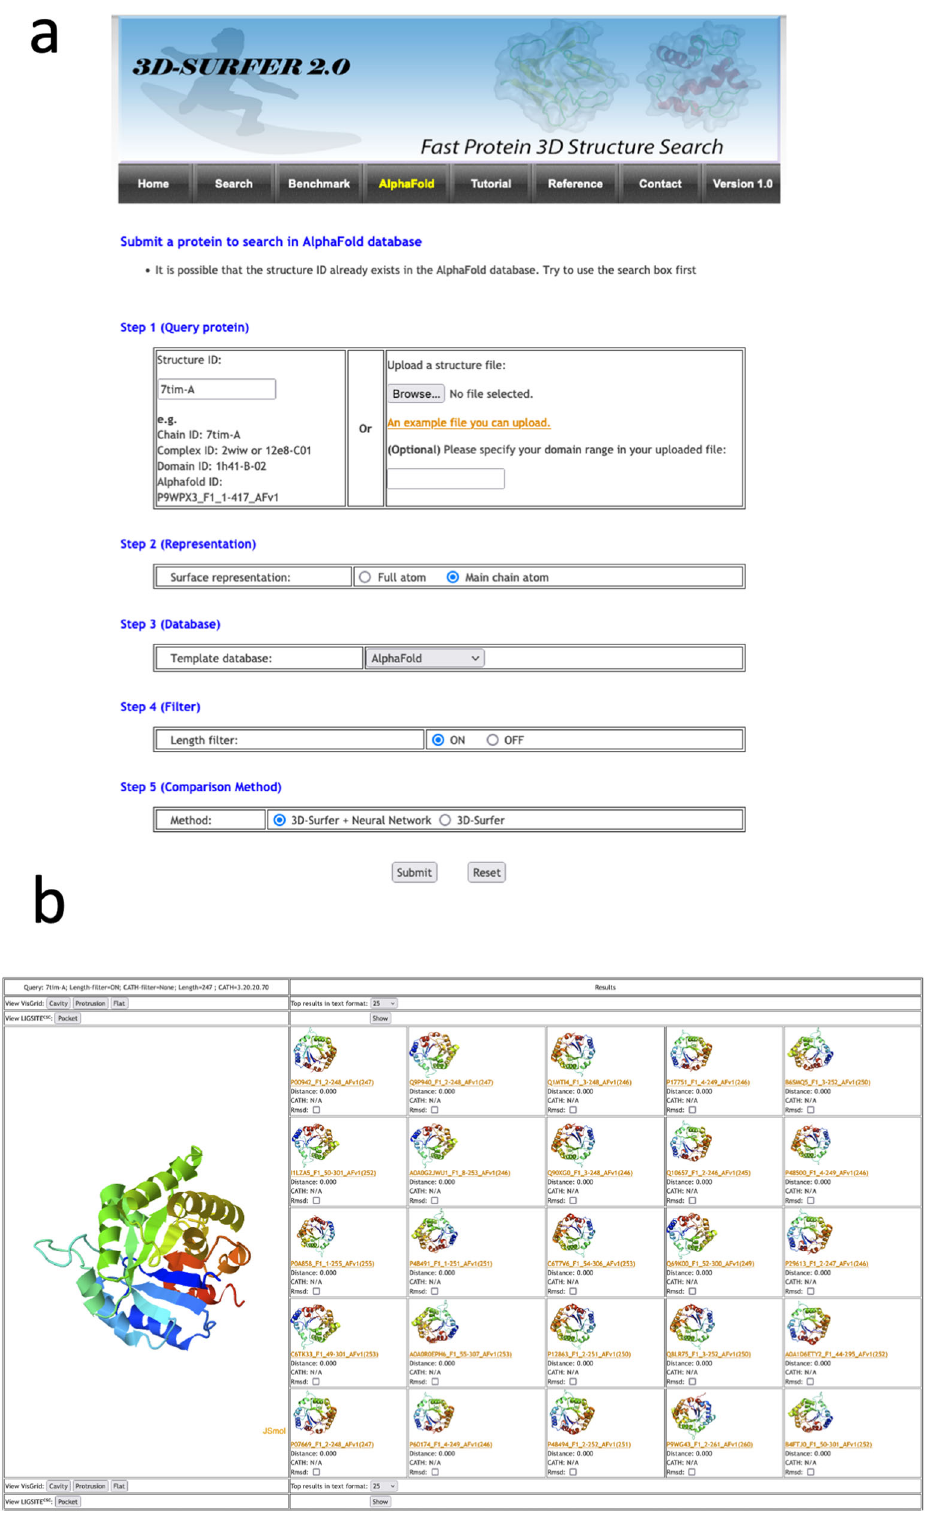
Fig. 1 Input and an output example of 3D-AF-Surfer. a The input page (see text). b An example output page. The query was PDB ID: 7tim-A, a TIM-barrel fold and search was against AlphaFold2 models using the deep neural network. As shown, retrieved top 25 hits are all TIM-barrel folds with a distance of 0.0, indicating that the network judged that these structures are highly likely to belong to the same fold.